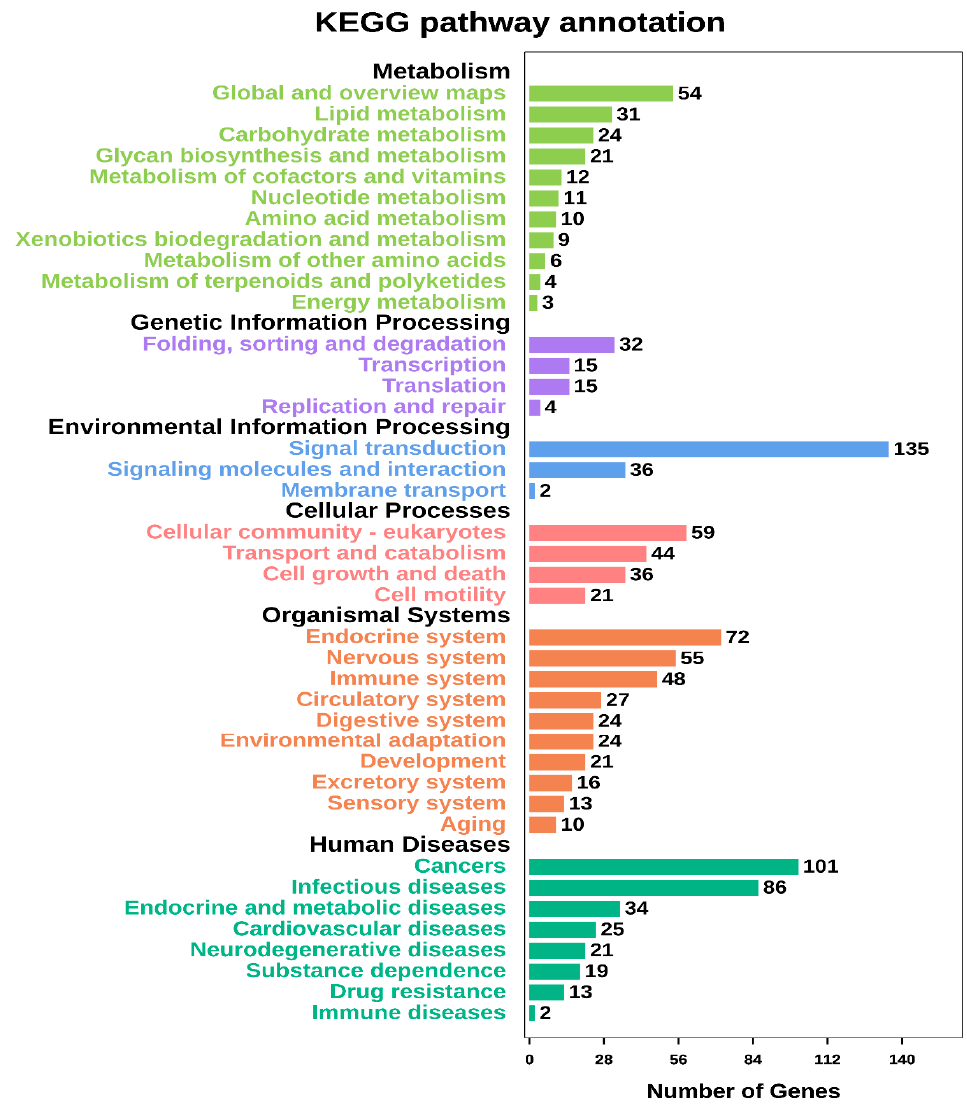
Figure 3. Enriched KEGG pathways of the predicted target genes of the differentially expressed miRNAs between the high and low backfat groups.